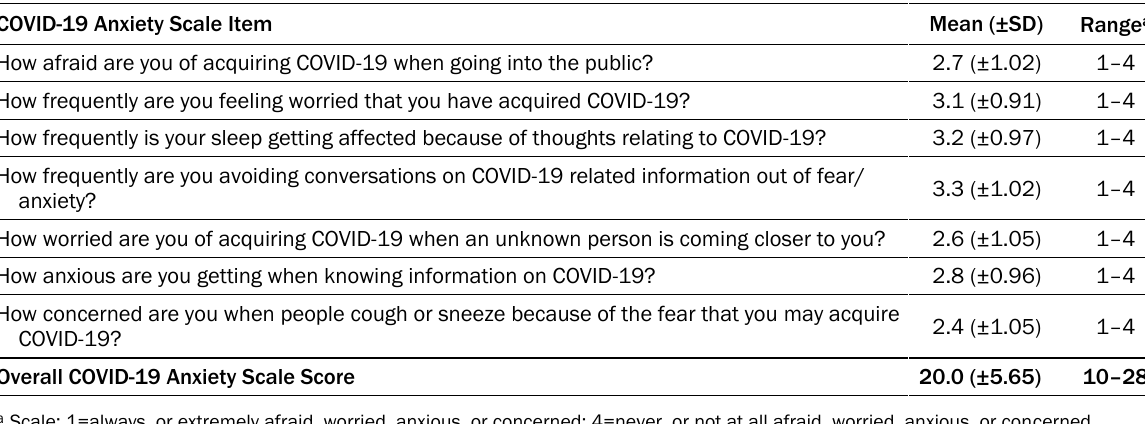
Table 5. Item-Level and Overall Mean, Standard Deviation, and Range of COVID-19 Anxiety Scale Scores Among a Sample of Tennessee